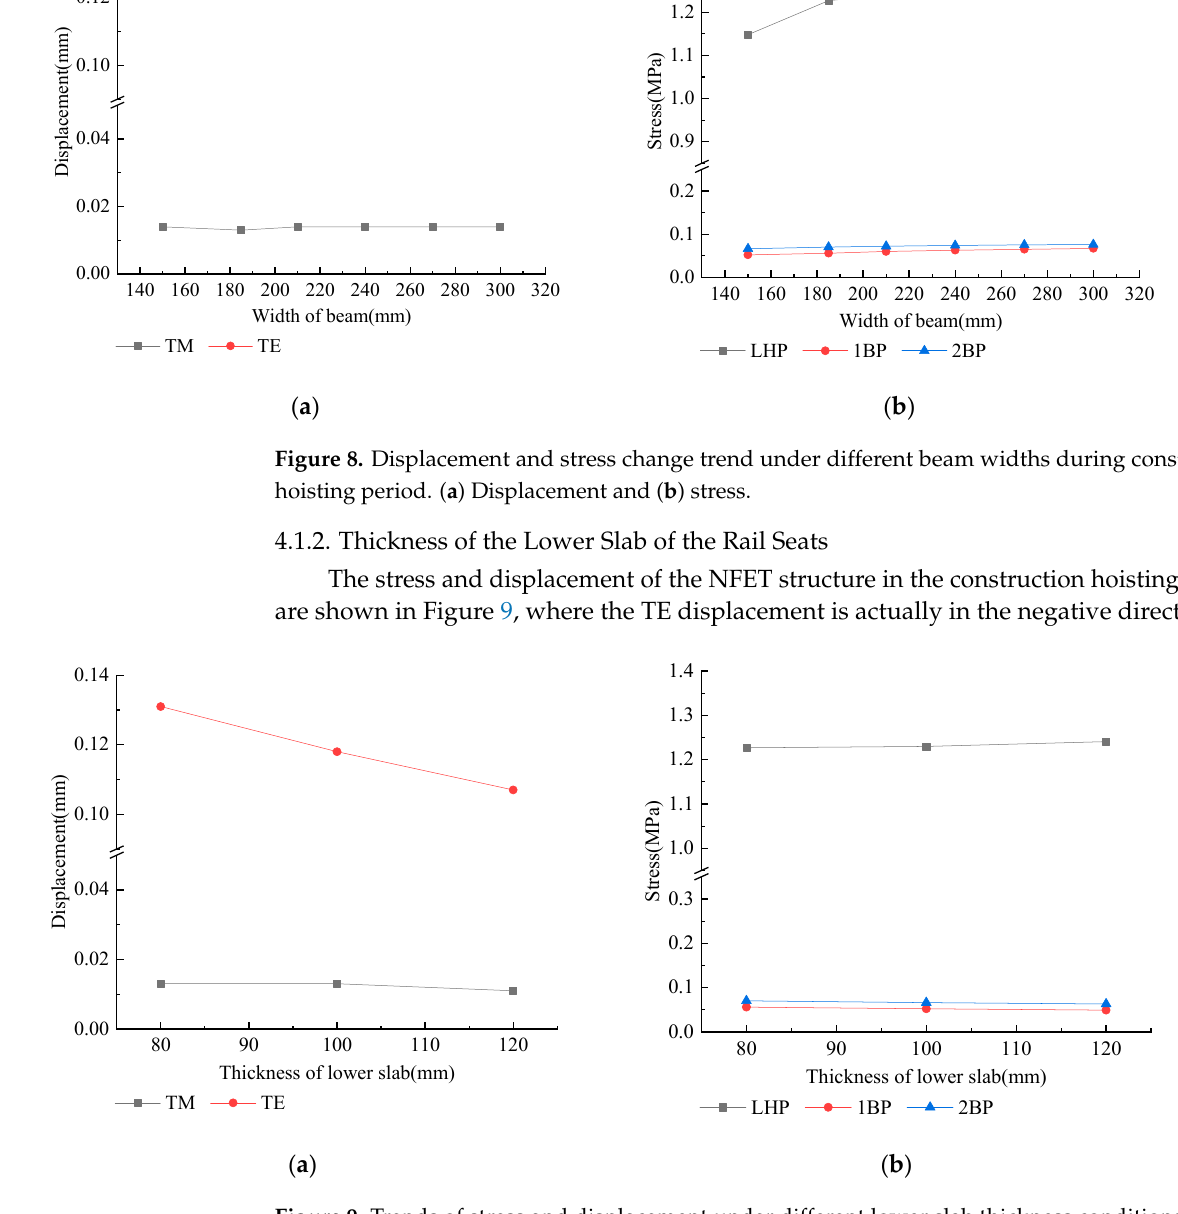
( b ) Figure 10. Stress and displacement in the hoisting period of construction. ( a ) Displacement and ( b ) stress. According to Figure 10, when considering the pipelines, the LHP stress has increased by 13%, and the displacement and stress of other positions are basically unchanged. On the one hand, the gravity of the track slab in this period is borne by the LHP completely.